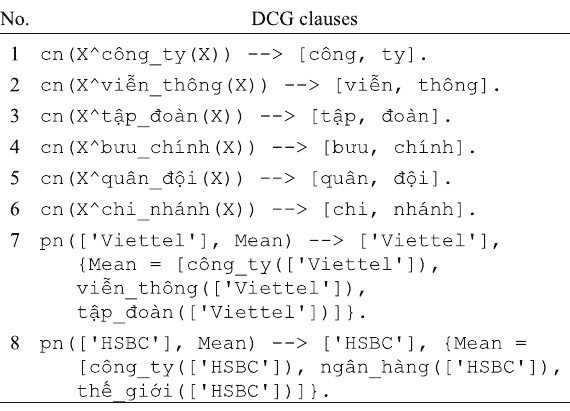
Table 1 DCG clauses of the semantics form of lexicon (common noun and proper